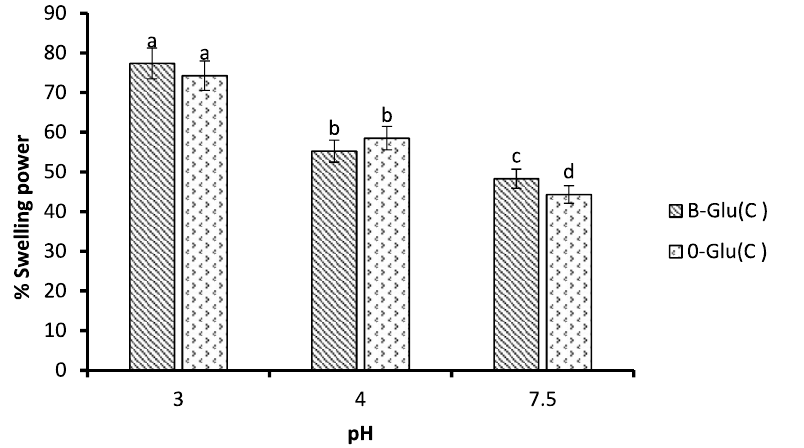
Figure 3. Swelling power of B-Glu (C) and O-Glu (C). B-Glu (C) represents catechin encapsulated in barley β -glucan, and O-Glu (C) is catechin encapsulated in oats β -glucan. Different letters on the bars at different pH indicate significant difference ( p <